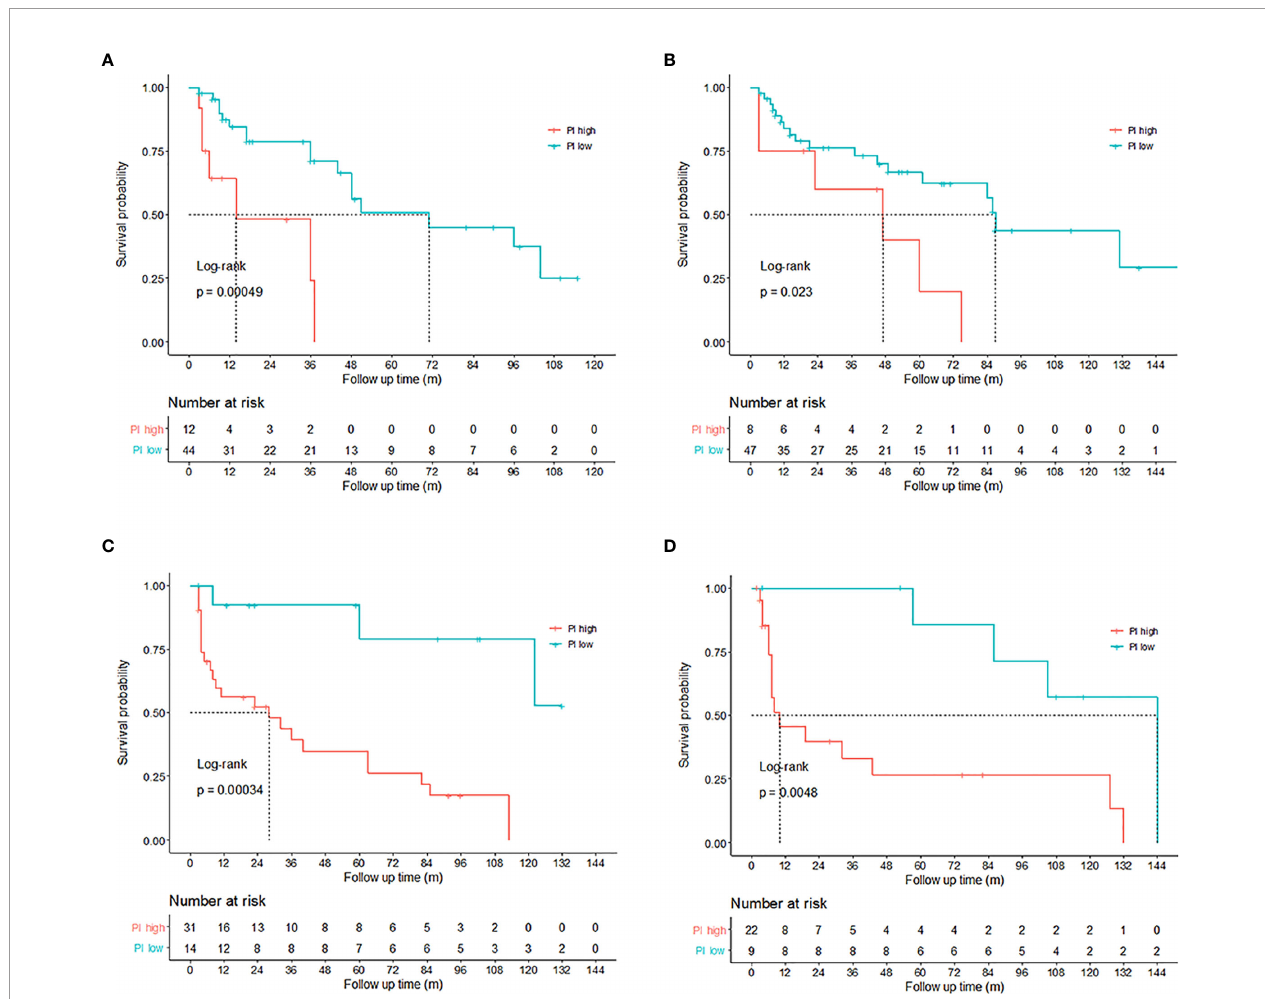
FIGURE 4 | Validation of the prediction models for non-muscle-invasive bladder cancer (NMIBC) and muscle-invasive bladder cancer (MIBC). High prognostic index (PI) (PI>1.5095) indicated poor disease-free survival (DFS) (p<0.05) for NMIBC patients in the (A) training set (n=56) and (B) validation set (n=55). MIBC patients with PIs higher than 2.2079 tended to have poorer DFS (p<0.01) in the (C) training set (n=45) and (D) validation set (n=31). The differences between the high PI group and the low PI group were assessed by the log-rank